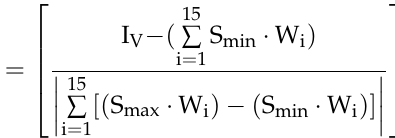
From the above-presented equation, the vulnerability curves depend on three main factors, that are the normalized vulnerability index (V I ), the hazard, expressed in terms of macroseismic intensity (I), and a ductility factor, Q, which was herein assumed as equal to 2.3 and describes the ductility of typological classes of buildings examined